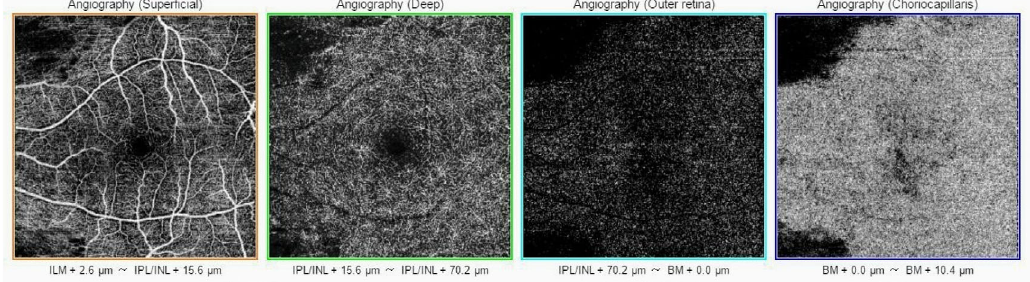
Figure 3. Baseline OCT-A of the left eye shows no flow in superficial and deep retinal capillary plexuses microvasculature. Only the flow in cilioretinal artery is